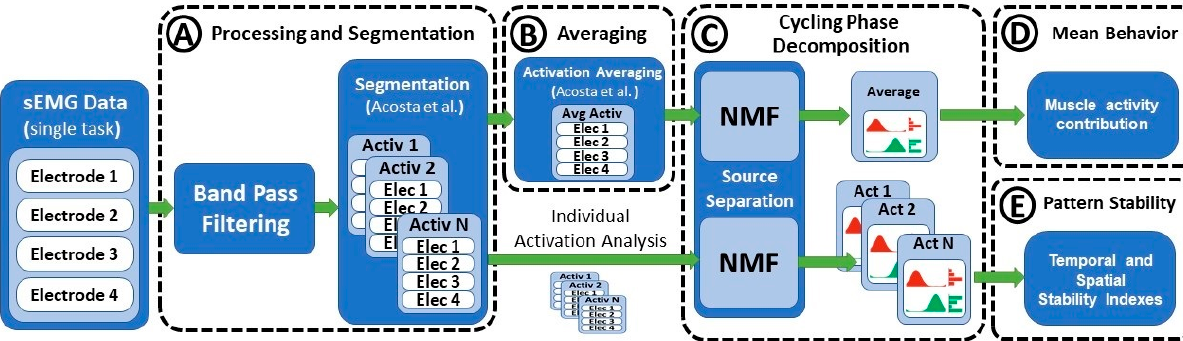
Figure 3. Parameter computation flow: ( A ) filtering processing and segmentation; ( B ) averaging of pedaling cycles; ( C ) extraction of cycling phases; ( D ) estimation of amplitude contribution of each muscle and cycling phase; ( E ) estimation of temporal and stability indexes.